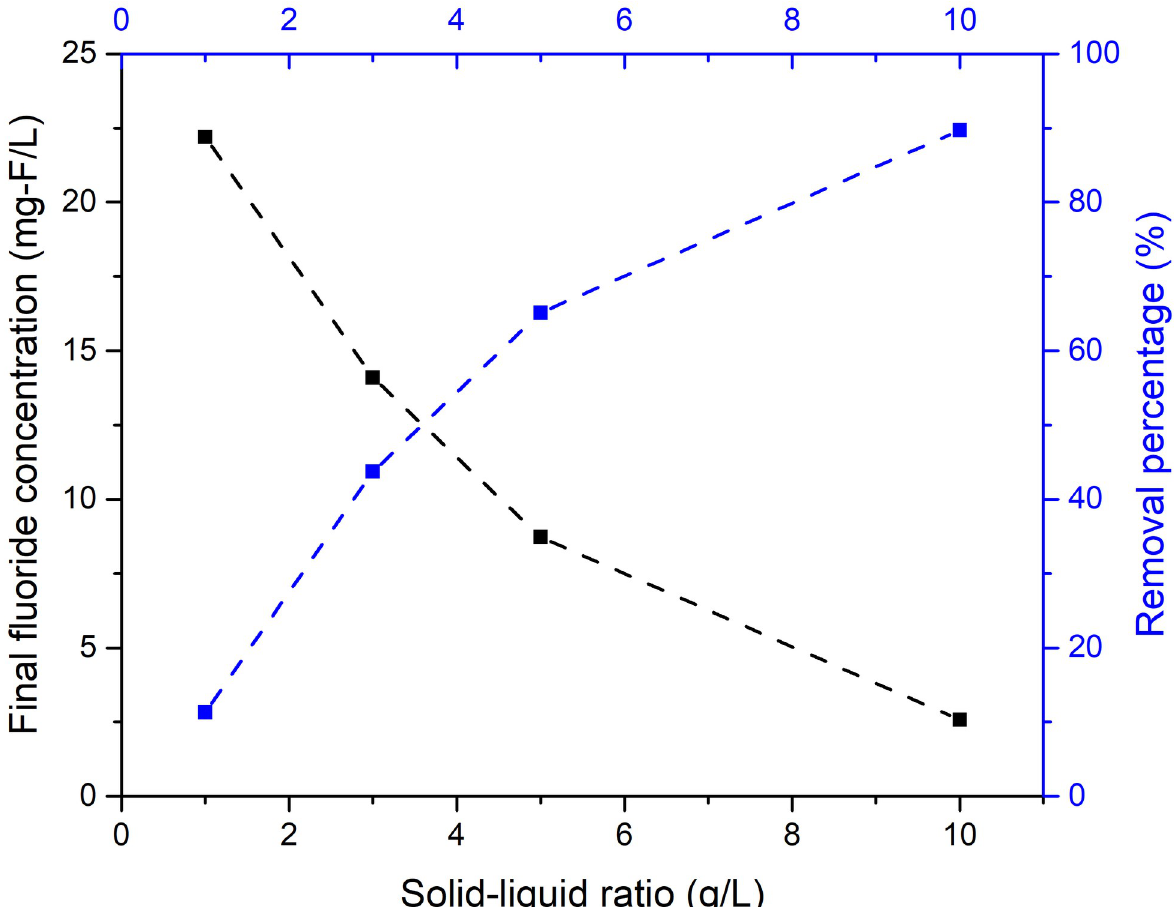
Fig 2. Final fluoride concentration and percentage of fluoride removed at various solid–liquid ratios for metaettringite.